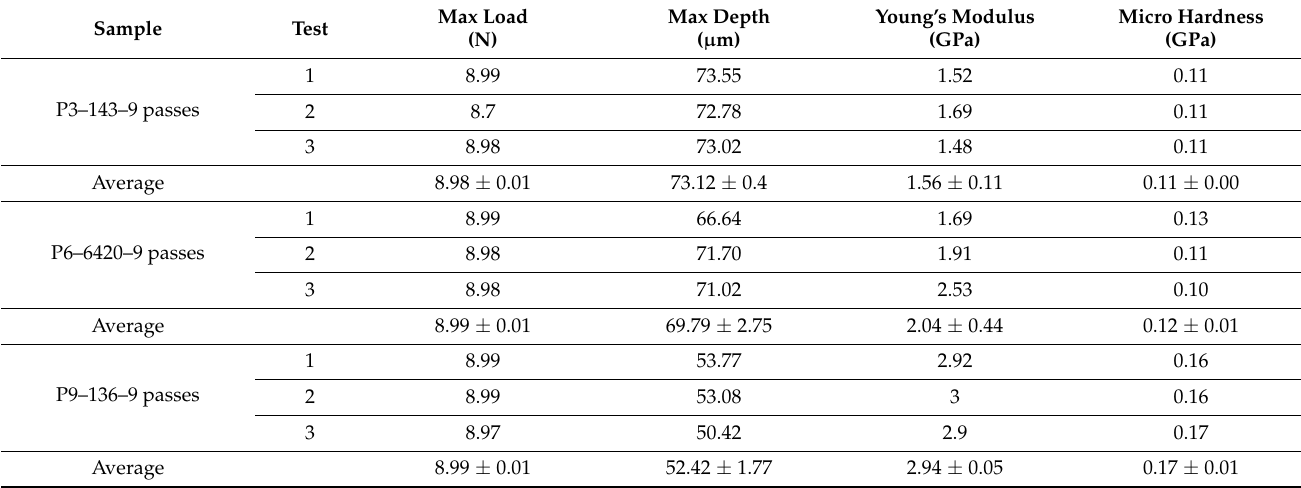
Table 6. Results obtained by microindenting the samples coated with ceramic